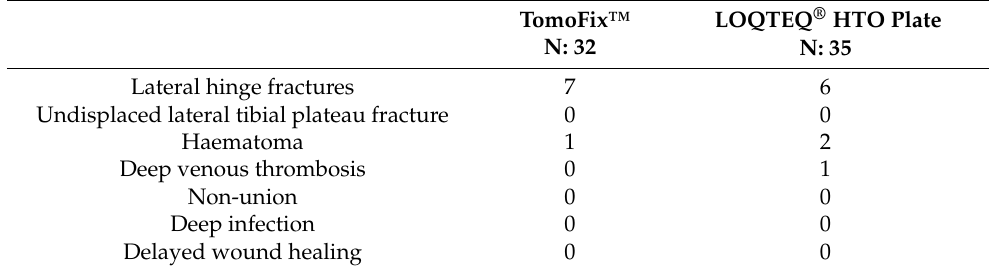
Table 4. Adverse